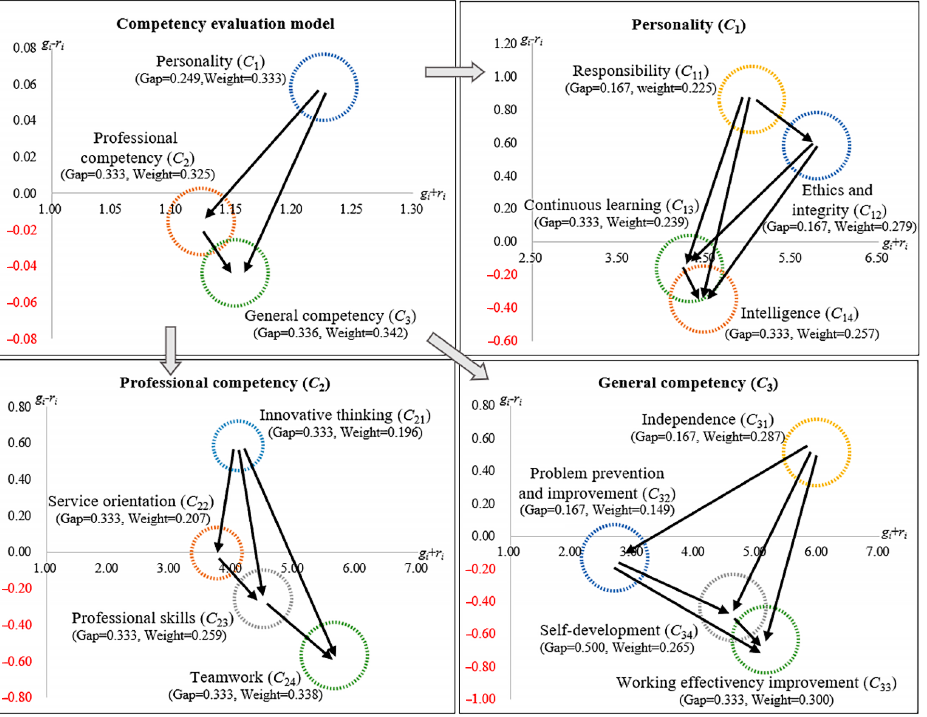
Figure 4. Data-driven ISNRM for improving F